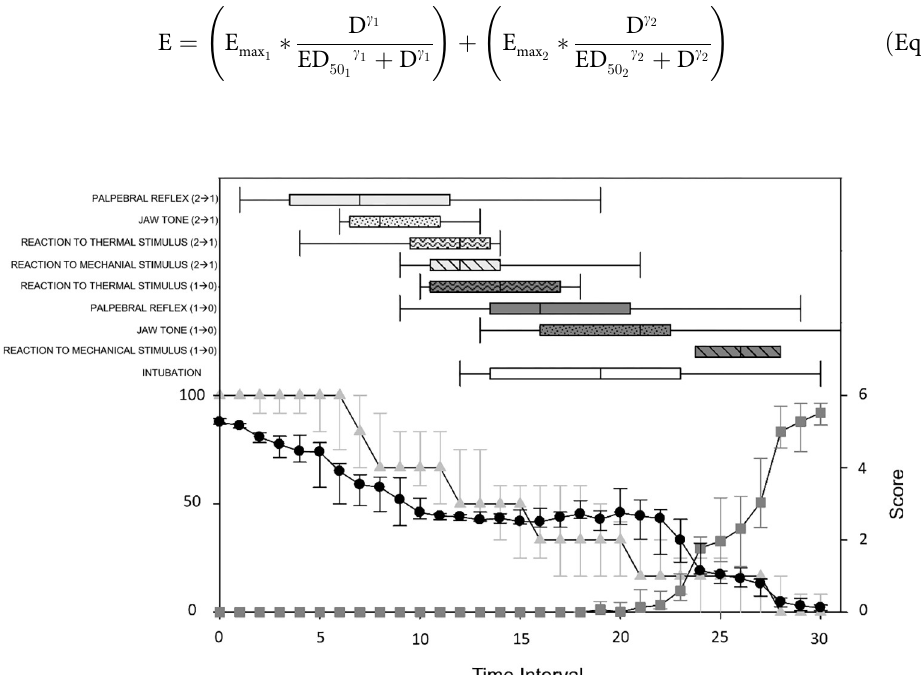
Fig 1. Sedline-generated and clinical variables over time. Median (interquartile range) for patient state index (black dots), suppression ratio (dark grey squares), and clinical depth of anaesthesia score (light grey triangles) during increasing propofol infusion in nine pigs. The individual durations of propofol administration were divided in 30 equal time intervals (TI) for each pig (TI 1 to TI 30 ). T 0 = baseline values. Box plots (median and 25-75th percentiles) represent the time intervals at which the different clinical outcome scores changed (in